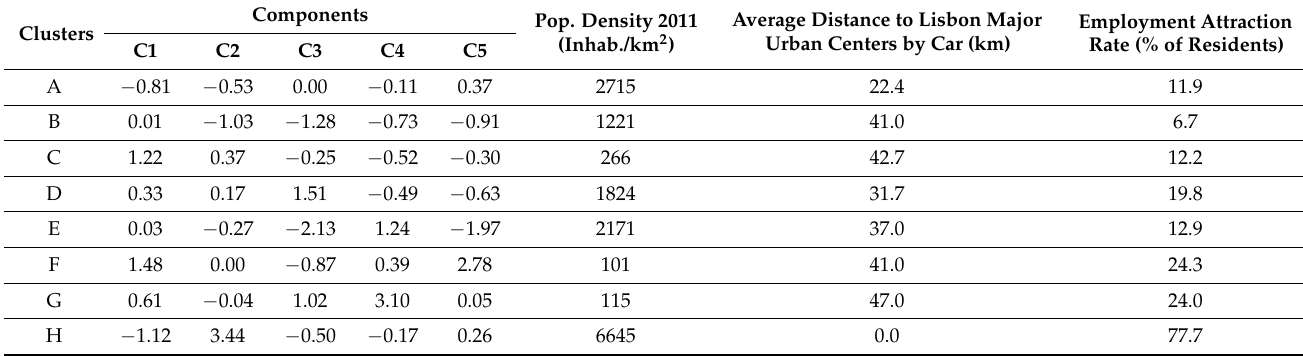
Table A1. Cluster scores and socioeconomic variables by PCA component.